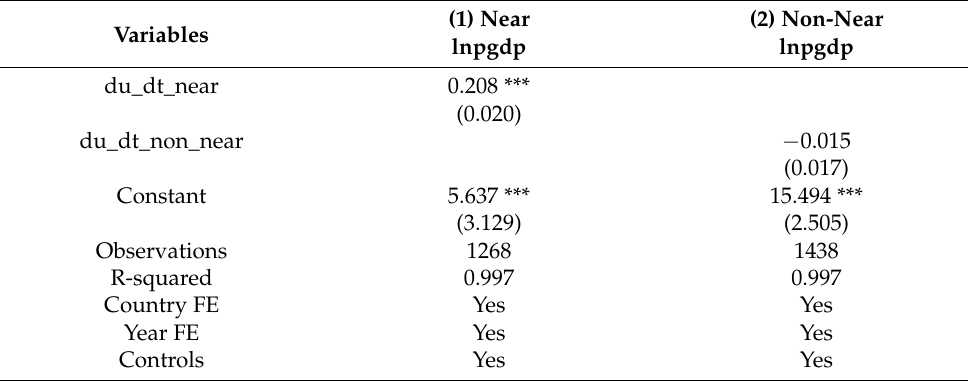
Table 6. The distinction of near and non-near